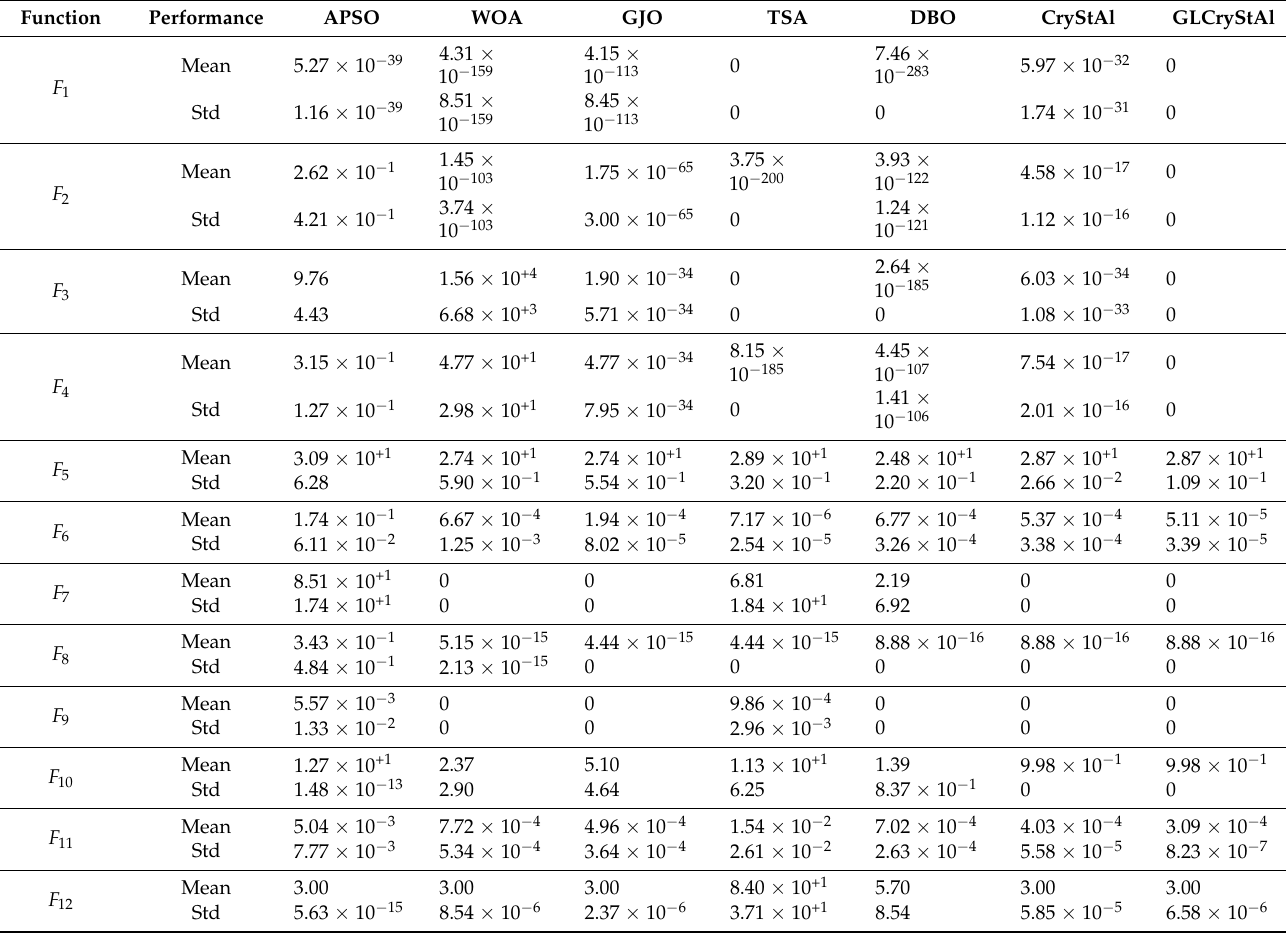
Table 3. Experimental results in 30 dimensions.